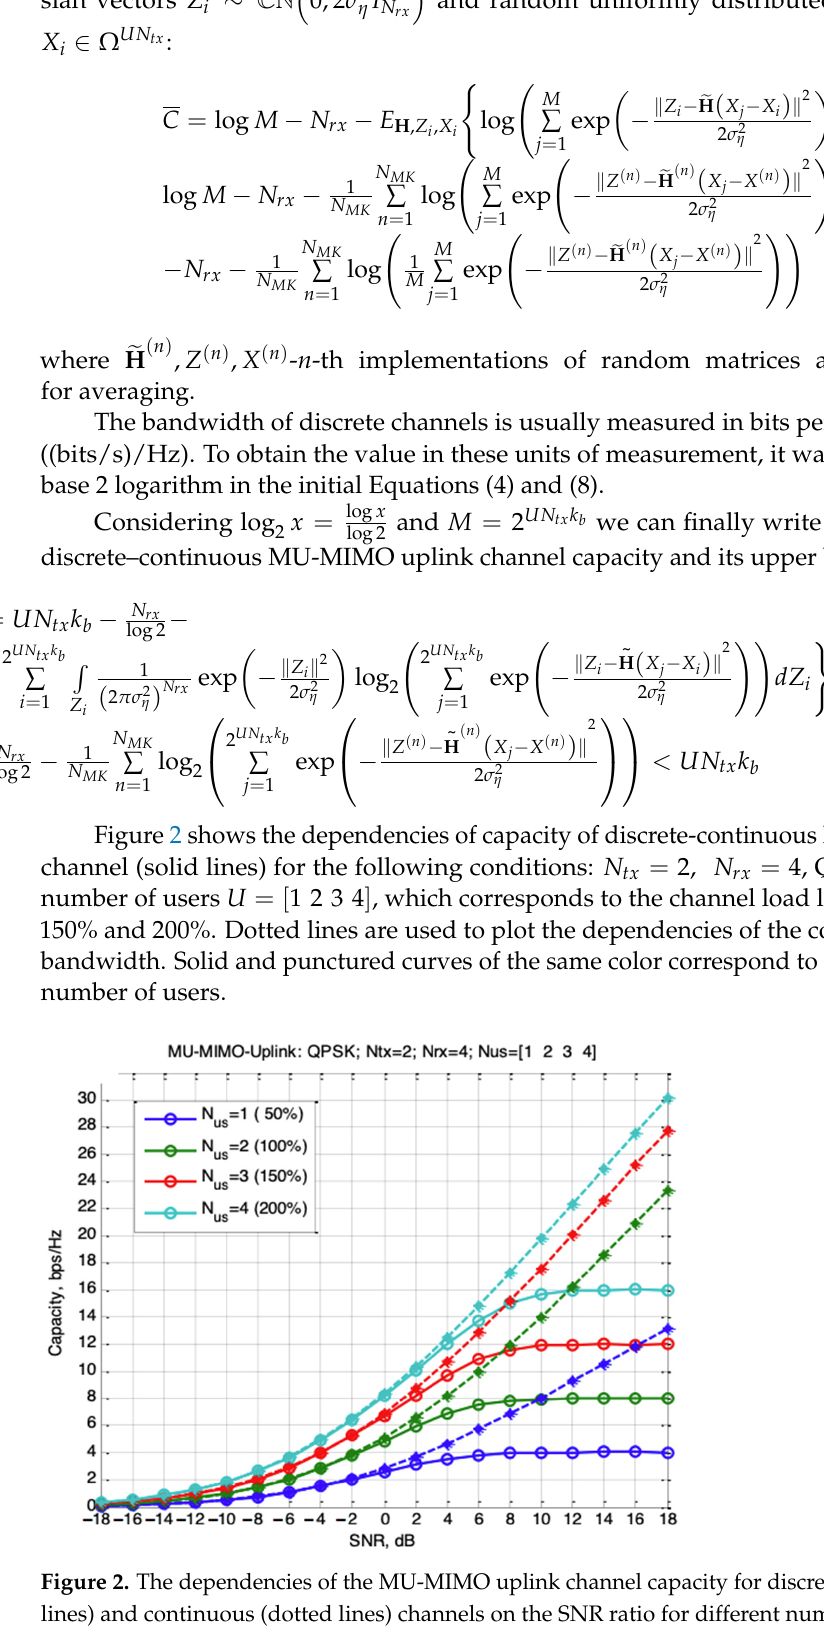
Figure 3. The dependence of MU-MIMO uplink total channel rate for discrete–continuous channel on the number of users of different values of the SNR ratio. The results on Figures 2 and 3 show that for a discrete–continuous channel with high SNR ratios the total channel rate increases linearly with the number of users. This allows us to conclude that such systems can work in overload mode. 4. Simulation of MU-SISO and MU-MIMO Uplink System in Overload Mode For a demonstration of the potential possibilities of using the overload mode, we consider the case of receiving, on one receiving antenna at the base station, signals from several users, i.e., consider the MU-SISO uplink system